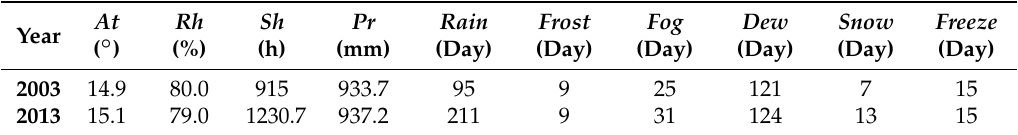
Table 5. The main climate indexes of 2003 and